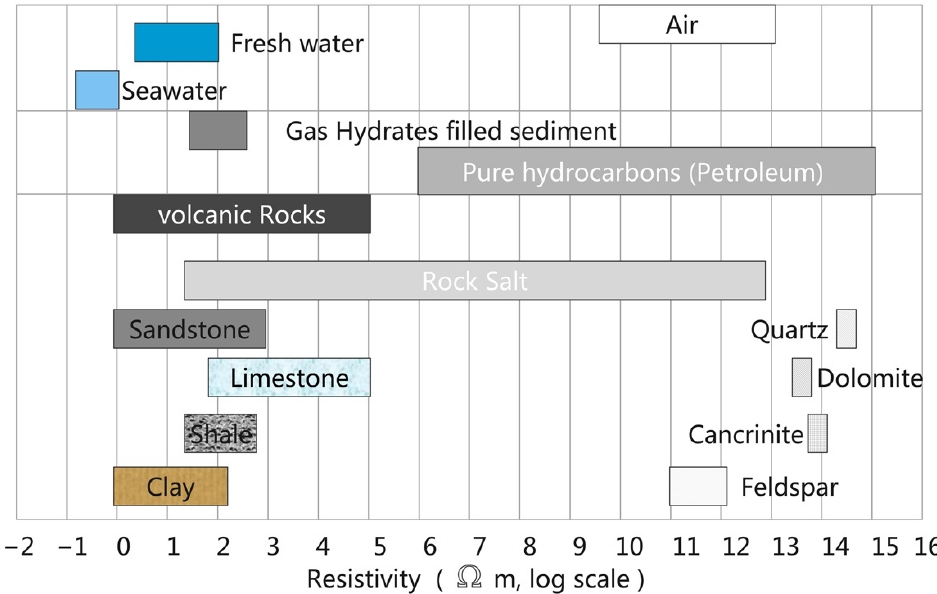
Figure 1. Resistivity ranges of different common materials. The resistivity of crystalline and volcanic rocks is dominated by the matrix resistivity, while the resistivity of sedimentary rocks is dominated by the porosity, water saturation, and the resistivity of the pore water. The gas hydrate resistivity here refers to the bulk resistivity of the sediment containing gas hydrates found through geophysical exploration, not the value range of pure gas hydrates (this figure was adapted from [33] ).